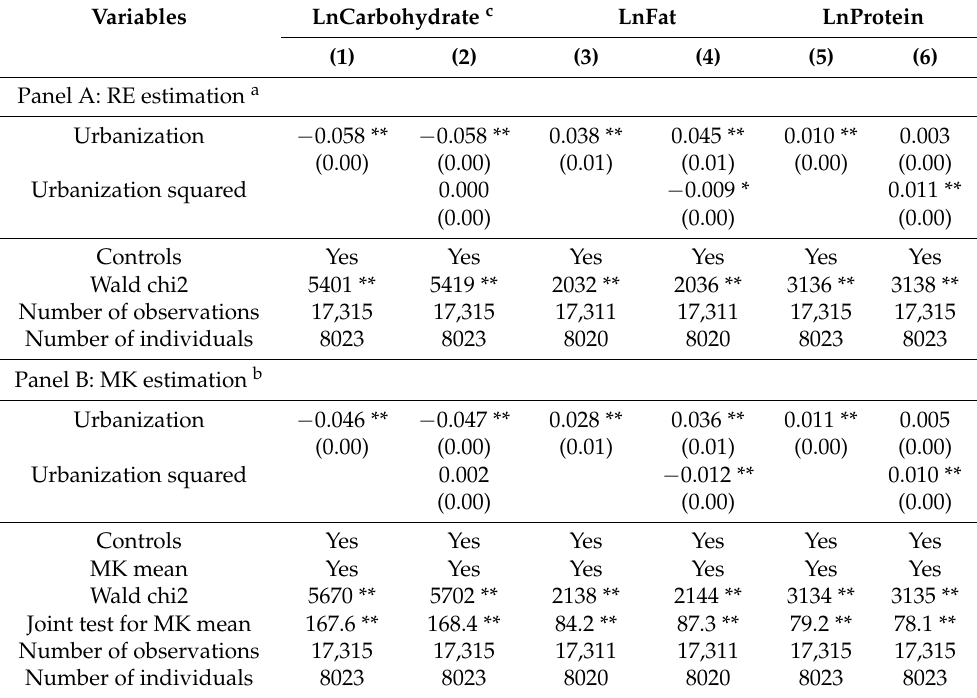
Table 3. The effect of urbanization on the intake of macronutrients.